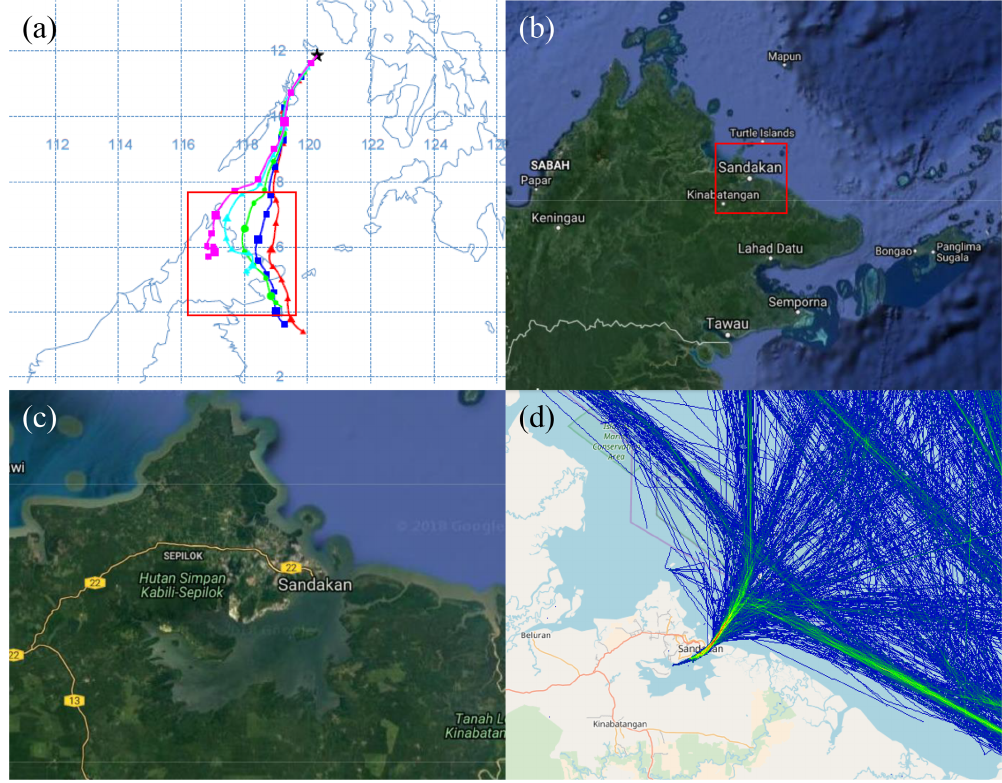
Figure 10. Determination of the 18 September event using (a) HYSPLIT back trajectories, (b, c) a Google Maps view of the northeastern coast of Borneo (map data ©2018 Google), and (d) the density of shipping traffic from Sandakan, Sabah (source: MarineTraffic). Red squares indicate the location of the succeeding